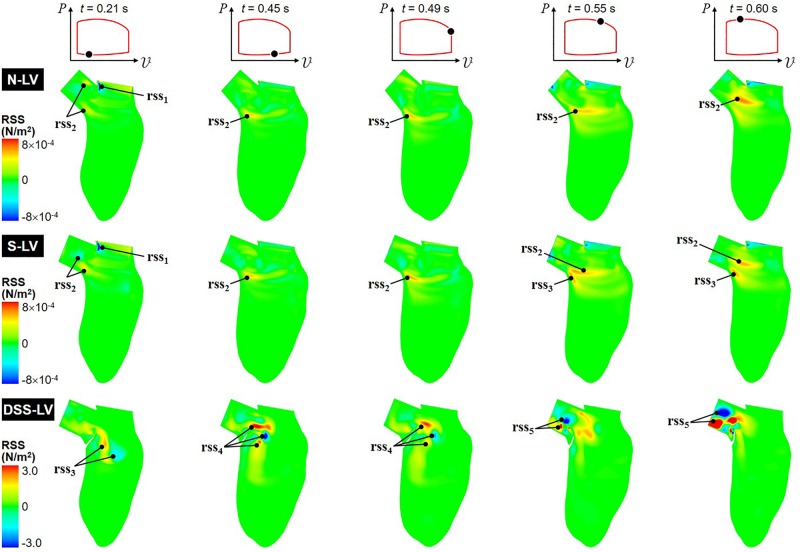
Snapshots of the RSS contour fields captured in the N-LV, S-LV, and DSS-LV models during early ventricular filling (0.21 s), late filling (0.45 s), early systole (0.49 s), acceleration phase (0.55 s), and at peak systole (0.60 s).